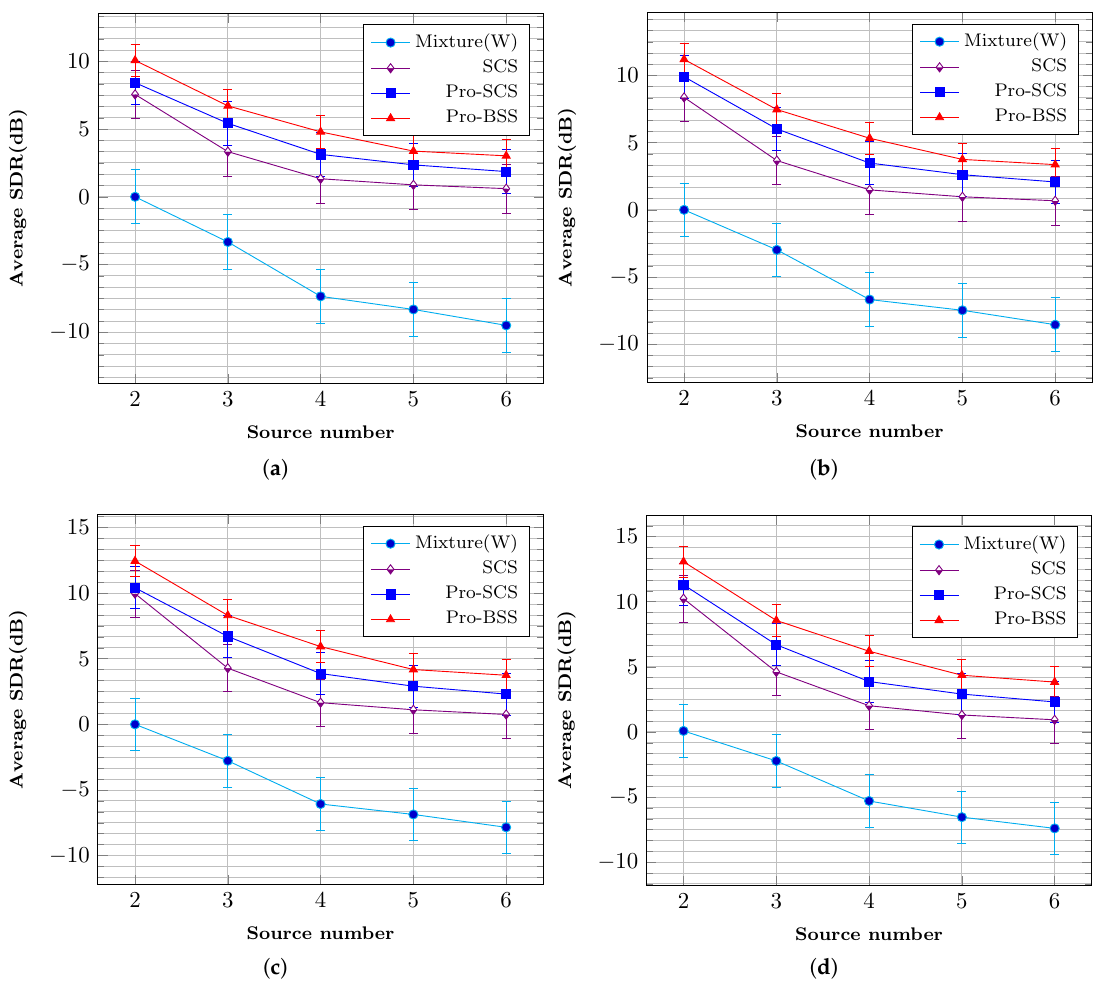
Figure 11. SDR results. Error bars represent 95% confidence intervals, ( a – d ) represent the results for separations {30 ◦ , 40 ◦ , 50 ◦ , 60 ◦ }, SNR = 20 dB, RT 60 = 0.5